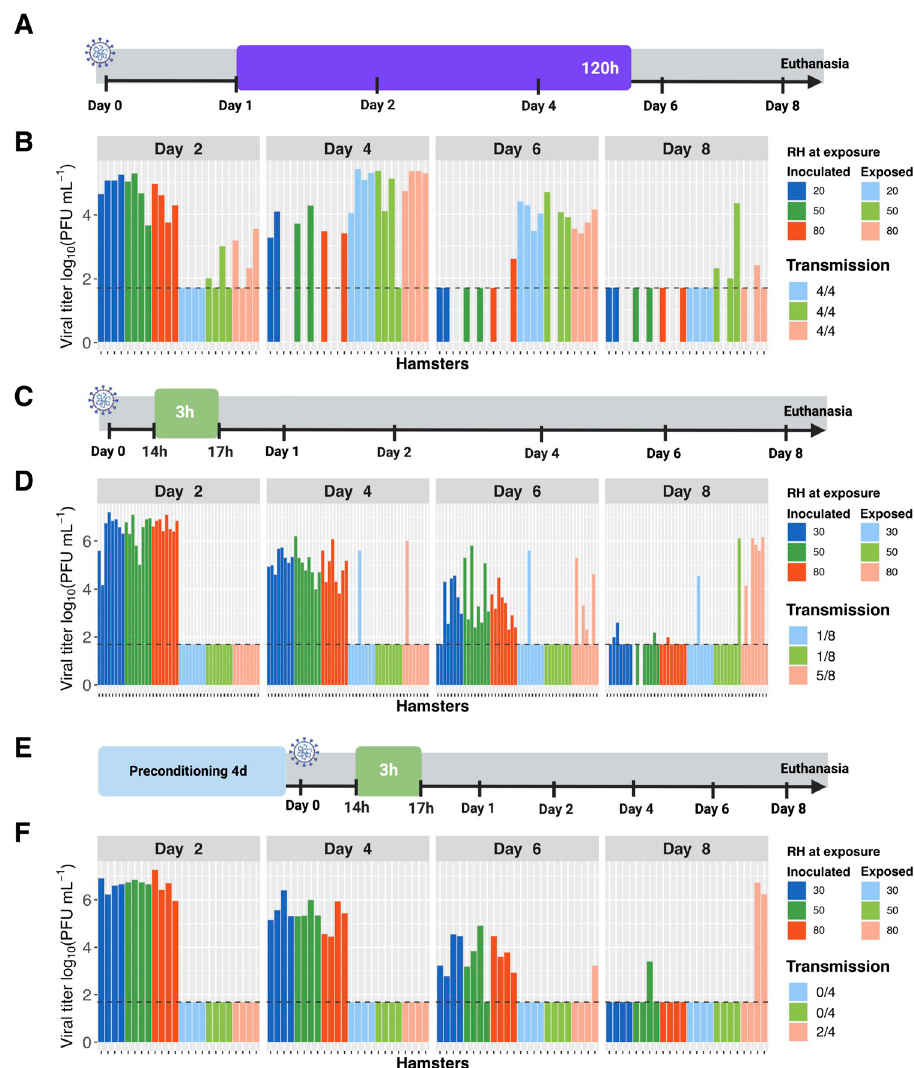
Fig 4. Low humidity does not promote SARS-CoV-2 transmission in hamsters. A, C, E] Schematic diagrams depicting experimental timeline. Animals were inoculated at Day 0 and exposures initiated at Day 1. Colored boxes show different exposure conditions, with the duration indicated within each box and the start times indicated with black ticks. B, D, F] Viral titers in nasal lavage samples collected from inoculated [dark colors] and exposed [light colors] hamsters are plotted. Facets show results from 2-, 4-, 6- and 8-days post-inoculation [dpi] with different colors indicating the RH of exposure. A, B] Donor animals were inoculated with 1x10 4 PFU [titered on VeroE6 cells] and contacts were exposed for a period of five days under the indicated RH conditions, beginning at 24 hpi. N = 4 transmission pairs. C, D] Donor animals were inoculated with 1x10 2 PFU [titered on VeroE6 cells] and contacts were exposed for a period of 3 h under the indicated RH conditions, beginning at 14 hpi. Data are combined from two independent experiments, giving a total of n = 8 transmission pairs. Comparison between 30% RH or 50% RH and 80% RH using Fisher’s exact test revealed that differences were not significant [P = 0.12]. E, F] Donor and contact hamsters were preconditioned to the tested environmental RH for a period of four days. Donor animals were then inoculated with 1x10 2 PFU [titered on VeroE6 cells] and contacts were exposed for a period 3 h under the indicated RH conditions, beginning at 14 hpi. N = 4 transmission pairs. Comparison between 30% RH or 50% RH and 80% RH using Fisher’s exact test revealed that differences were not significant [P = 0.43]. Horizontal dashed line indicates limit of detection [50 PFU]. Missing data indicate that the animal died or was euthanized mid-way through the experiment. Temperature was 20˚C in all experiments